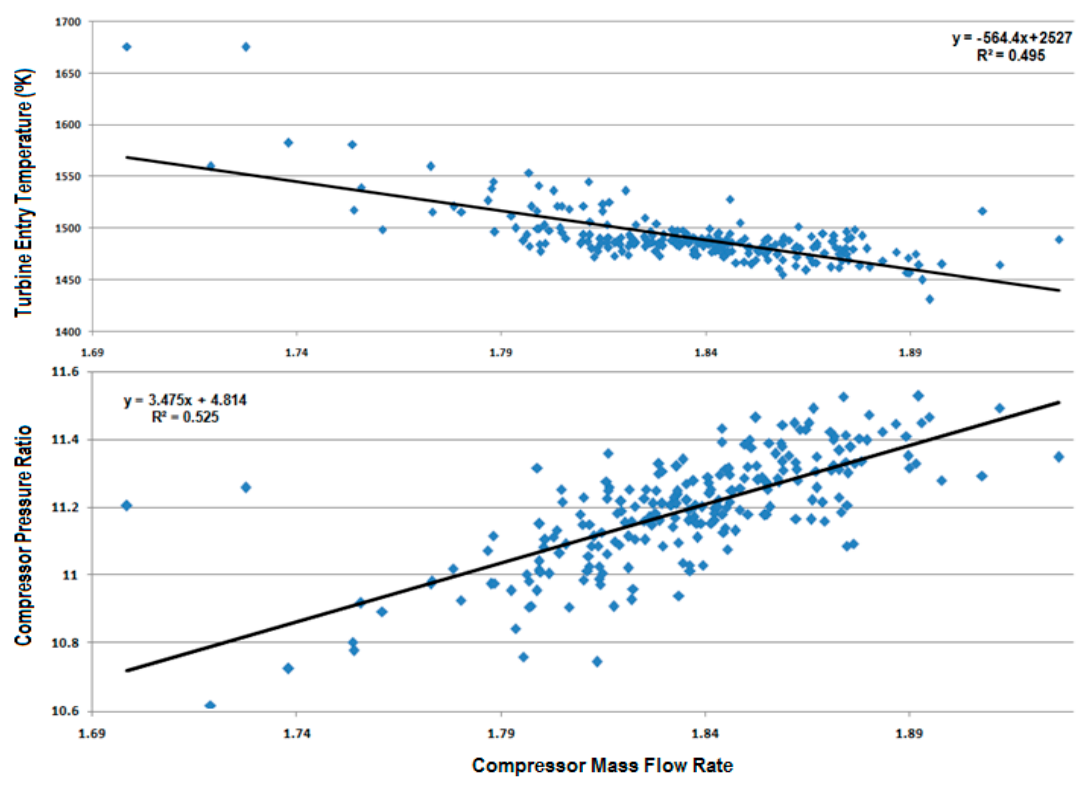
Figure 13. The Case study on Bi-directional Synthesis along the Axis of Performance.